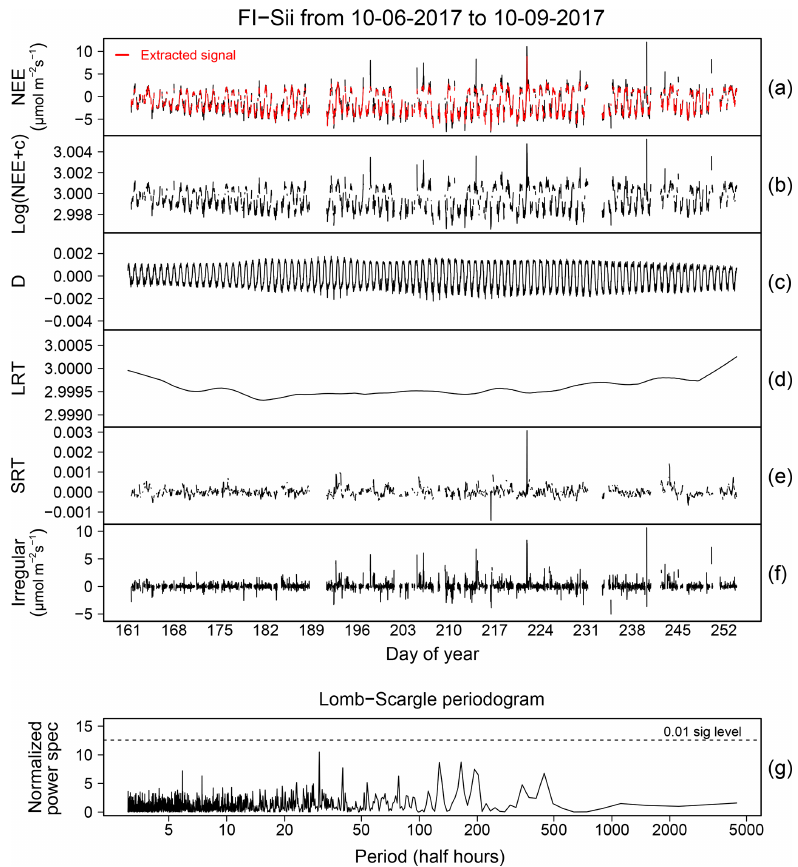
Figure 13. Example of STL decomposition applied to NEE time series collected at the FI-Sii site. Panel (a) shows the original NEE flux data; (b) shows NEE after log 10 transformation ( c is a constant added to ensure the argument of log is positive); (c) – (f) show the diurnal cycle ( D ), the long-run trend (LRT), the short-run trend (SRT) and the irregular component of the STL algorithm (see Sect. 2.3.1 for more details). Notice that the irregular component is depicted after inverse log transformation. Panel (g) shows the Lomb–Scargle power spectral density estimate applied to the irregular component of STL decomposition. Dashed line indicates the 0.01 significance level.